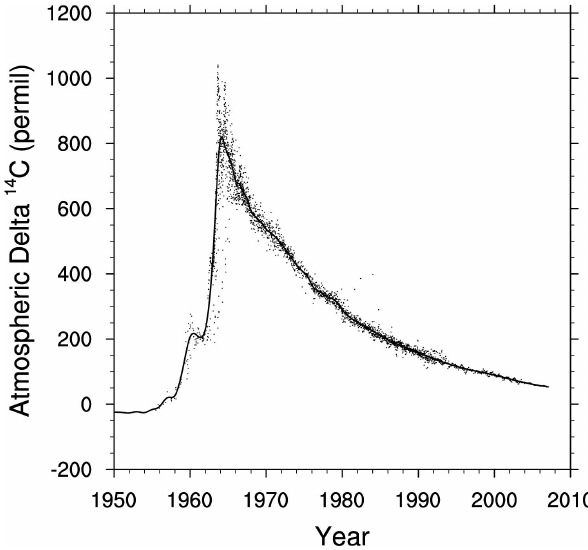
Fig. 3. Atmospheric observations of 1 14 C of CO 2 for the period 1950–2010 shown as dots (Levin and Kromer, 2004; Manning and Melhuish, 1994; Nydal and Lövseth, 1996; Turnbull et al., 2007). Spline approximation (solid line) used to force modeled 1 14 C of photosynthetic C inputs to CLM during transient 20th century sim-